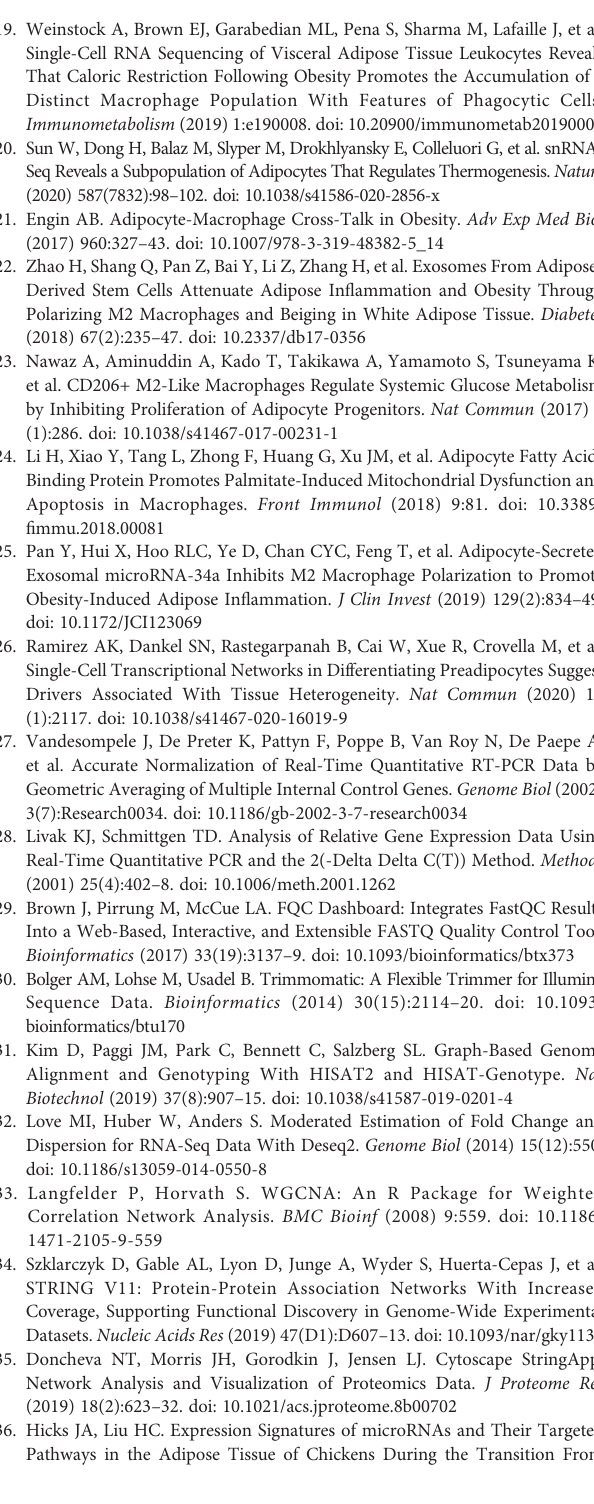
Supplementary Figure S1 | The expression of chemokines and their receptors in adipocyteandmacrophage. (A) :RelativemRNAexpressionofCcl2,Ccl5,Ccr2and Ccr5 in RAW264.7 macrophage and 3T3-L1 adipocyte; (B) : Relative protein